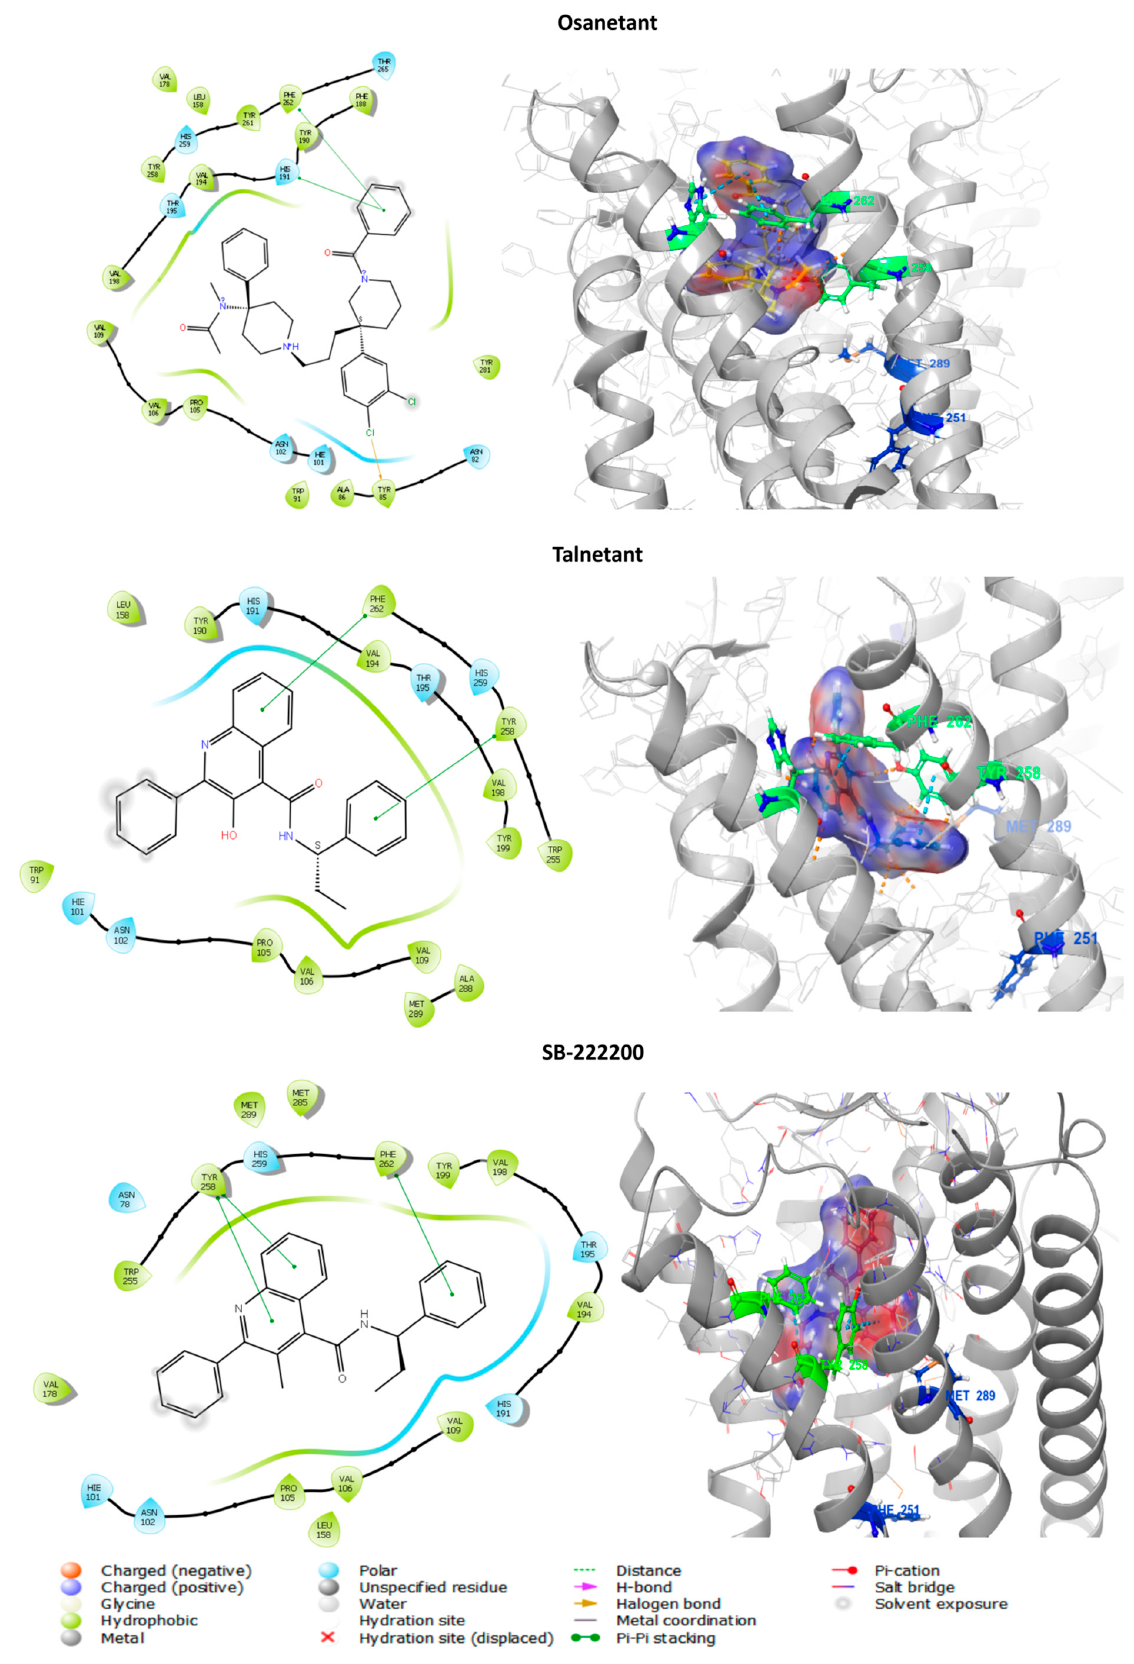
Figure 6. NKB antagonists docking on tiTac3Ra: Predicted docking of NKB antagonists Osanetant, Talnetant, and SB-222200.